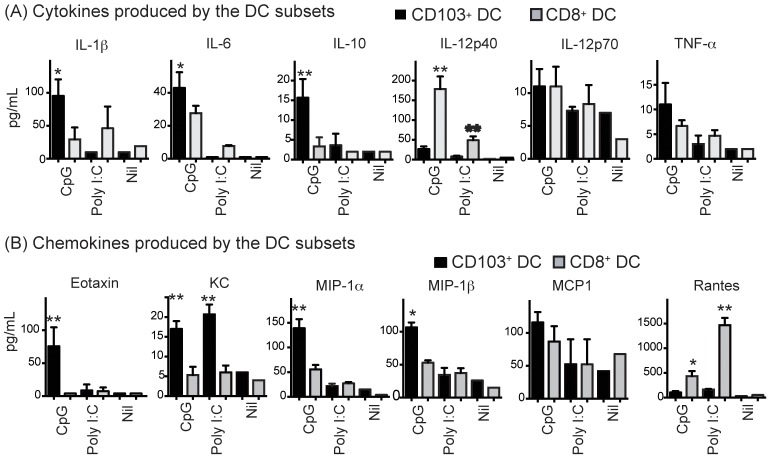
CD103+ DCs and CD8+ DCs produce different cytokines and chemokines.DCs were sorted from B6 mice and cultured at 5000 DCs per well in 96-well plates with (CpG or Poly I:C) or without (Nil) stimuli for 24 h. Exogenous GM-CSF (2 ng/mL) was included in cultures. Culture supernatants were assayed for cytokines (A) and chemokines (B). Data (mean ± SEM) are one of three individual experiments (*P<0.05, **P<0.01; Two tailed Student's T test).